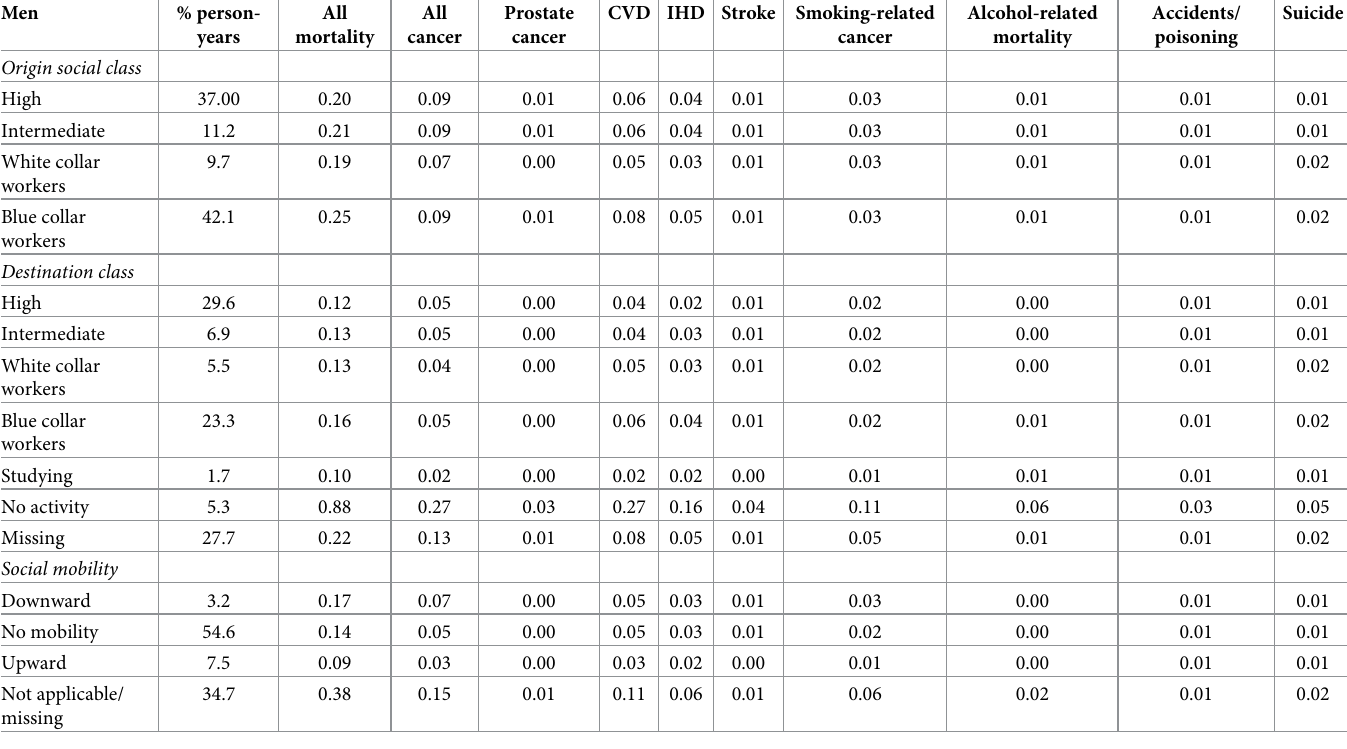
Table 2. Percent of all person-years for men in each status and percent of person-years ending in death by origin-, destination social class and social mobility.